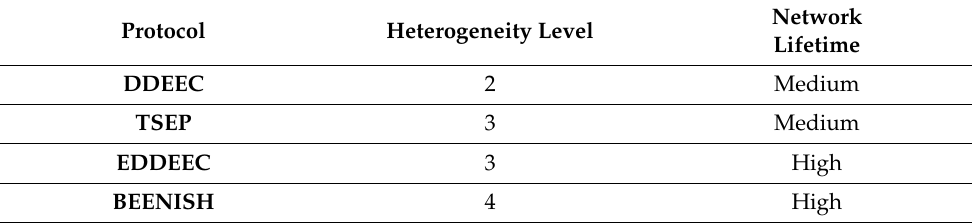
Table 6 establishes a comparison between heterogeneity-based routing protocols [80]. Table 6. Comparison of heterogeneity-based routing protocols for